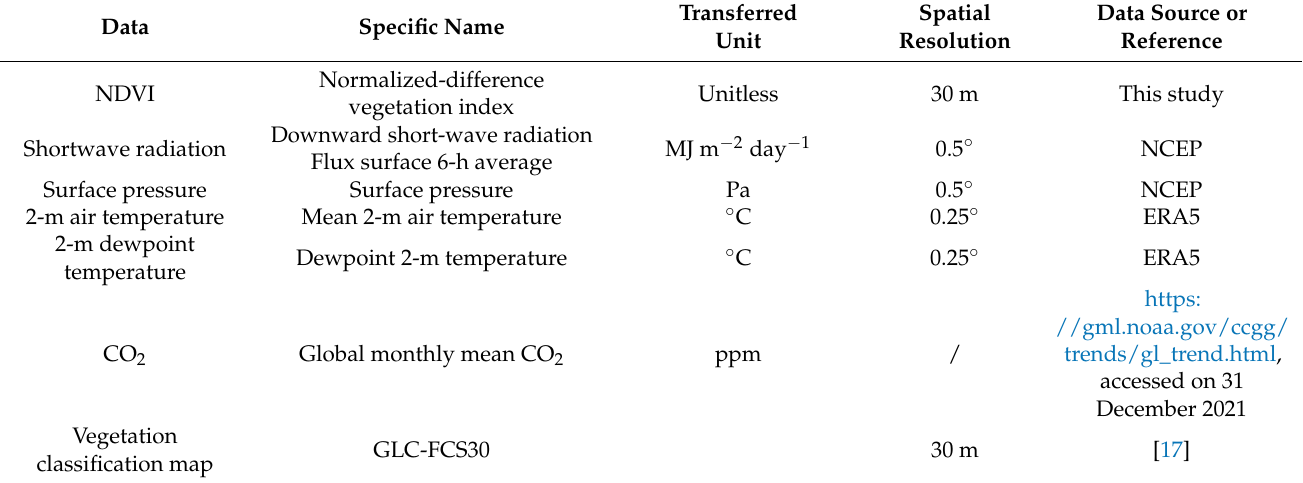
Table 2. Data sources for generating GPP on the GEE